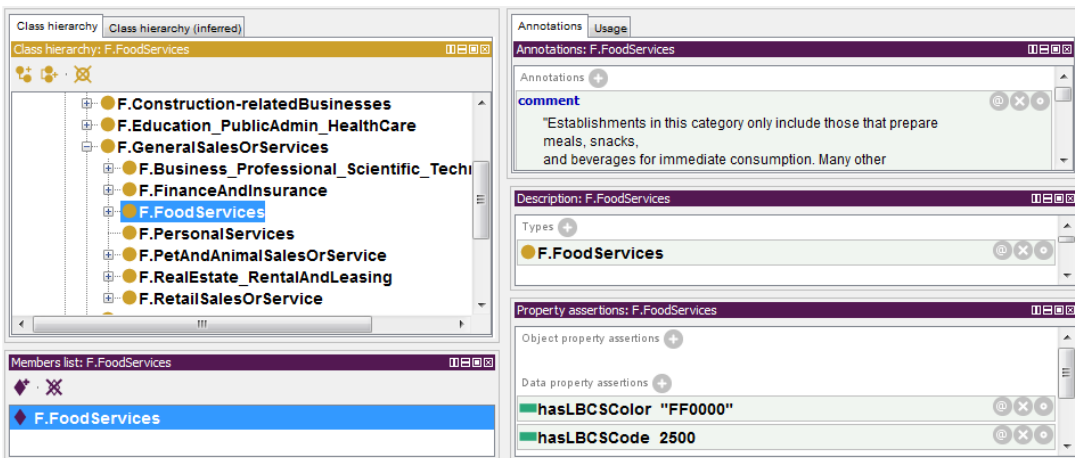
Figure 2. The LBCS concept. The LBCS concept seen as an individual with two datatype properties in which information about numerical and colour codes is